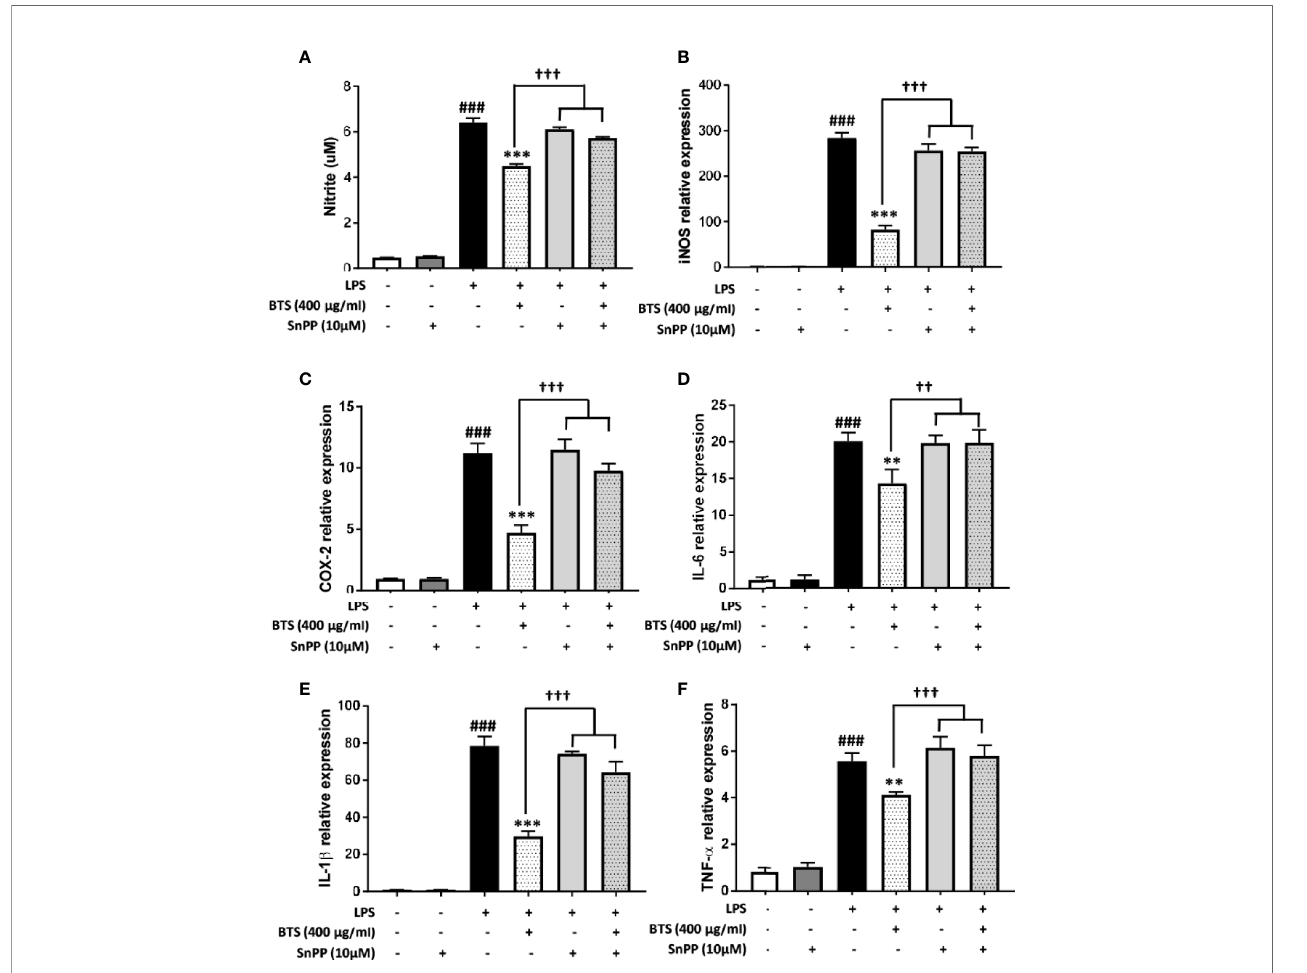
FIGURE 9 | HO-1 mediates the effect of BTS on NO production and mRNA expression of pro-in fl ammatory cytokines in BV2 cells. (A) BV2 cells were pretreated with BTS for 1 h in the presence or absence of SnPP (10 m M) and then stimulated with LPS (100 ng/ml) for 24 h. Levels of NO in the cell culture supernatant were measured by NO detection kit. (B – F) BV2 cells were pretreated with BTS for 1 h in the presence or absence of SnPP (10 m M) and then stimulated with LPS (100 ng/ ml) for 6 h. Levels of (B) Nos2 , (C) Cox2 , (D) Il6 , (E) Il1b , and (F) Tnfa mRNAs were determined by real-time PCR. Gapdh was used as a loading control. The data represent the mean ± SD of triplicate determinations (one-way ANOVA: ### p < 0.001 vs. untreated control; **p<0.01, ***p < 0.001 vs. LPS-treated control; †† p < 0.01, ††† p < 0.001 vs.